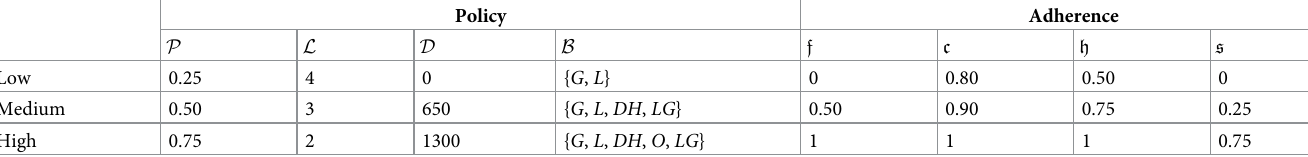
Table 5. The intervention parameter choices corresponding to different intensities for administrative policy (left) and student adherence (right). We describe in words Medium Policy and Medium Student Adherence as an example. Medium Policy screens P ¼ 0 : 50 of the student population weekly with a 3-day latency L . D ¼ 650 students are removed from the population. The gym, library, dining hall, and large gatherings are closed. Medium student adherence has half of students wearing face- masks while socializing f ¼ 0 : 50 . A c ¼ 0 : 90 proportion of students comply with screening tests. Students spend free time from building closures in their dorm room with R probability h ¼ 0 : 75 for each occurrence in their schedule. Additionally, students socialize less by a factor of ¼ 0 : 25 .